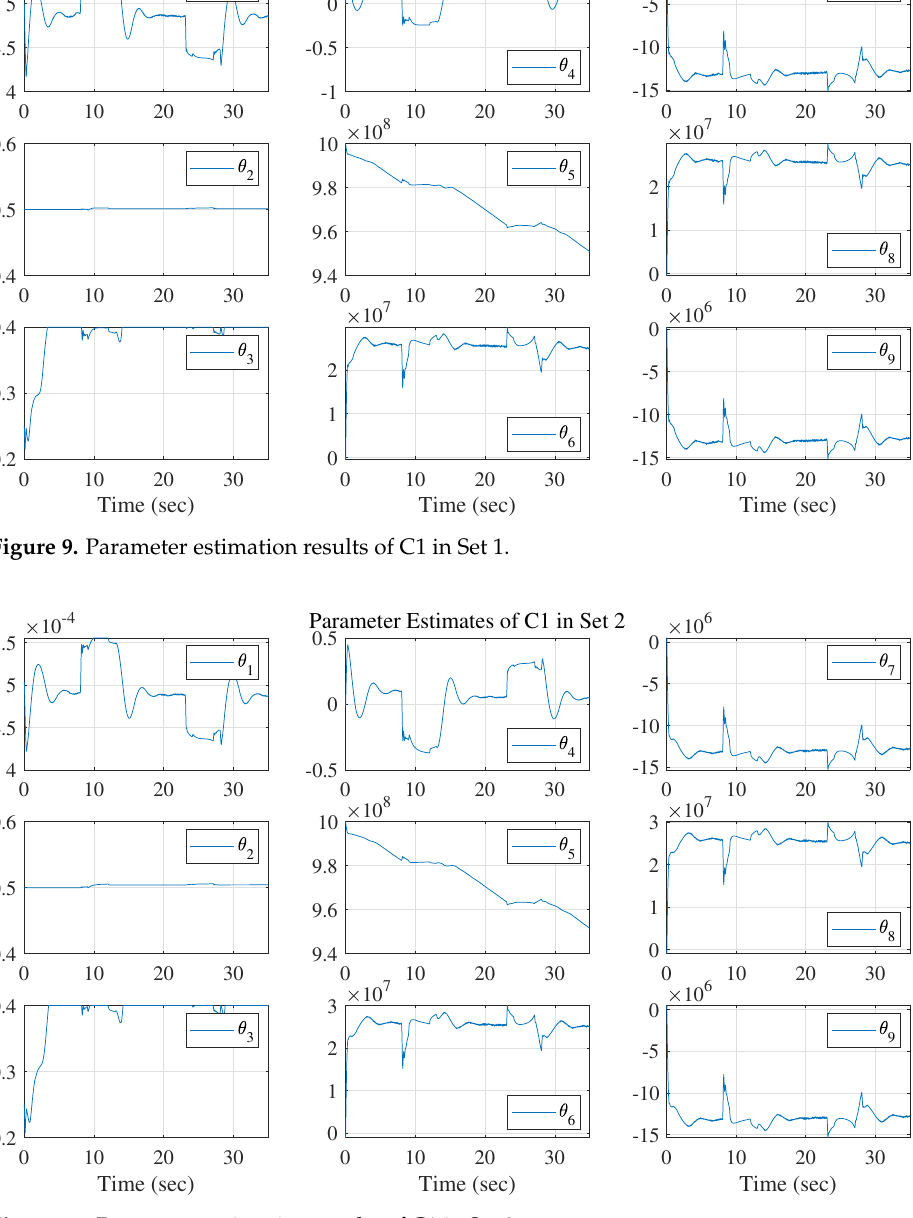
Figure 10. Parameter estimation results of C1 in Set